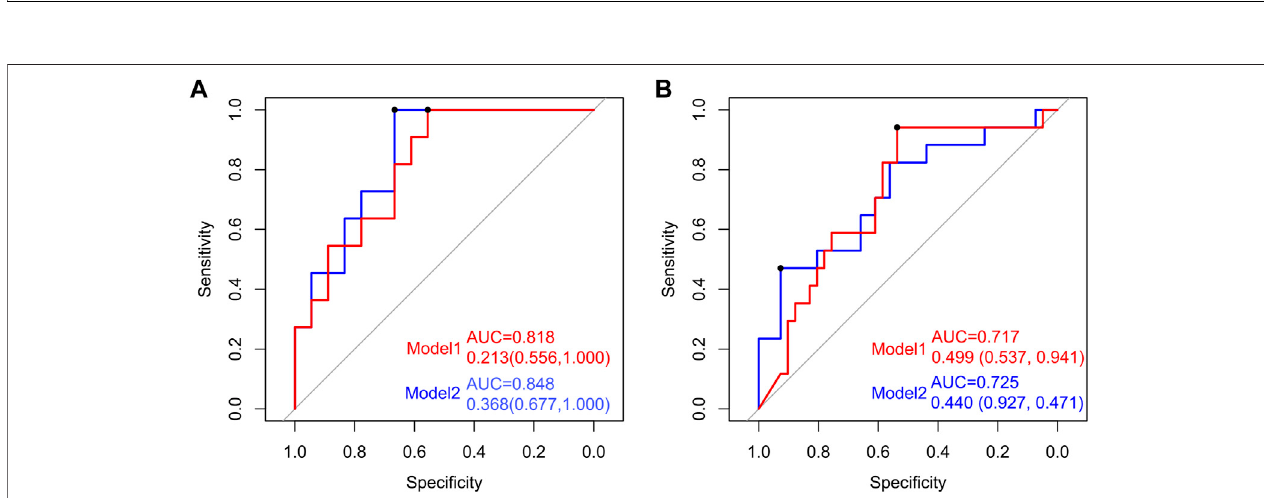
FIGURE6| Establishmentandveri fi cationofthepredictivemodelofOPbythegutmicrobiome.Receiveroperatingcharacteristic(ROC)curvesforpredictingOPin the training and test datasets. The red line indicates the ROC of model 1 ( Streptococcus sanguinis , Akkermansia muciniphila , and Bacteroides eggerthii ) based on multifactor logistic regression. The blue line signi fi es the ROC of model 2 ( Actinomyces graevenitzi i, Actinomyces odontolyticus , Streptococcus sanguinis , Akkermansia muciniphila , Bacteroides eggerthii , and Butyricimonas synergistica ).